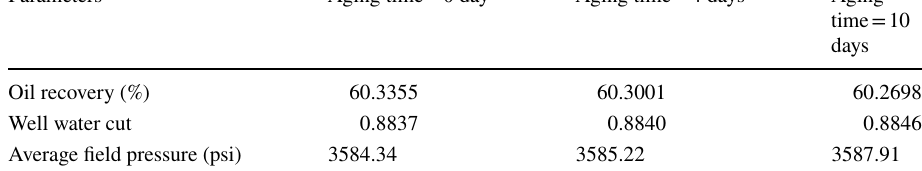
recovery, average field pressure and well water cut for various aging times at final simulation time